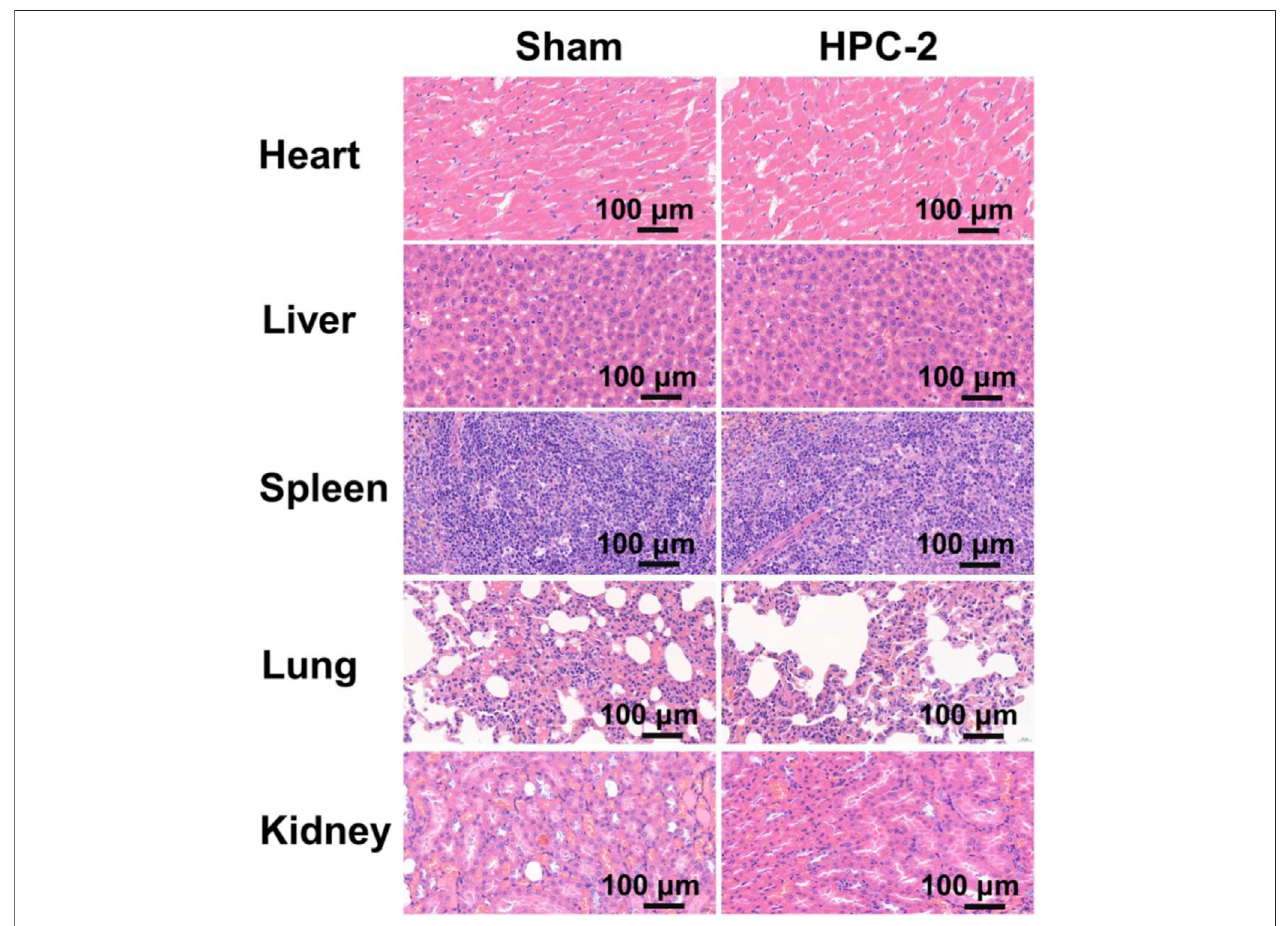
FIGURE 6 | Images of haematoxylin-eosin staining of the important organs of rats treated with HPC-2 hydrogel for 14 days.